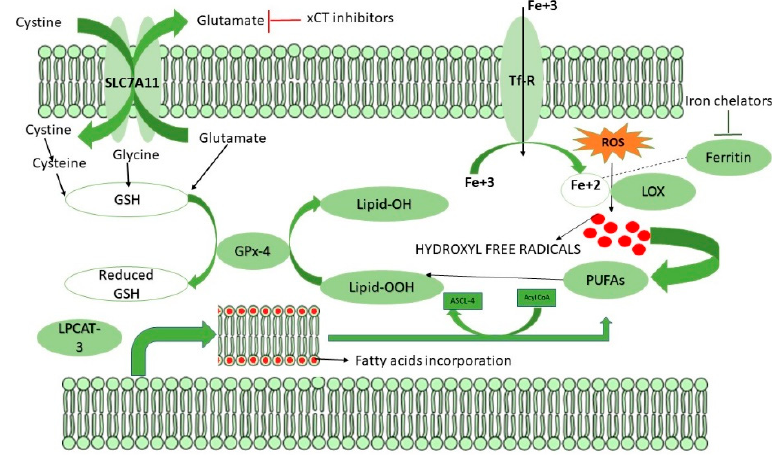
Figure 3. Possible mechanisms of inducing ferroptosis. Ferroptosis is a caspase independent cell death characterized by generation of lipid peroxides. Usually, under normal homeostasis if a cell needs to undergo ferroptosis, the cell enhances the generation of lipid peroxides with the help of various genes. Briefly, under unfavourable conditions, cellular ROS would be elevated which signals the cell membrane to incorporate fatty acids via LPCAT-3 enzyme, the fatty acids incorporated cell membrane would be further esterified by the ASCL-4 leaving poly unsaturated fatty acids (PUFAs) and acyl CoA. PUFAs would then interact with the hydroxyl free radicals produced by the generated ROS via LOX enzyme which requires ferrous iron through a process called Fenton reaction. Interestingly, there are two ways to induce ferroptosis in CSCs. The first mechanism to induce ferroptosis is by inhibiting SLC7A11. SLC7A11 is a cys-glu antiporter that imports cystine inside the cell by simultaneously exporting glutamate in a 1:1 ratio. The imported cystine is then reduced to two molecules of cysteine, which is then coupled with glutamate and glycine to form GSH. The formed GSH now acts as a co-factor for GPX4 and catalyses the conversion of lipid peroxides into lipid hydroxides, thereby halting ferroptosis. Secondly, ferroptosis could also be induced by iron chelators which degraded ferritin thereby enhancing LOX activity.